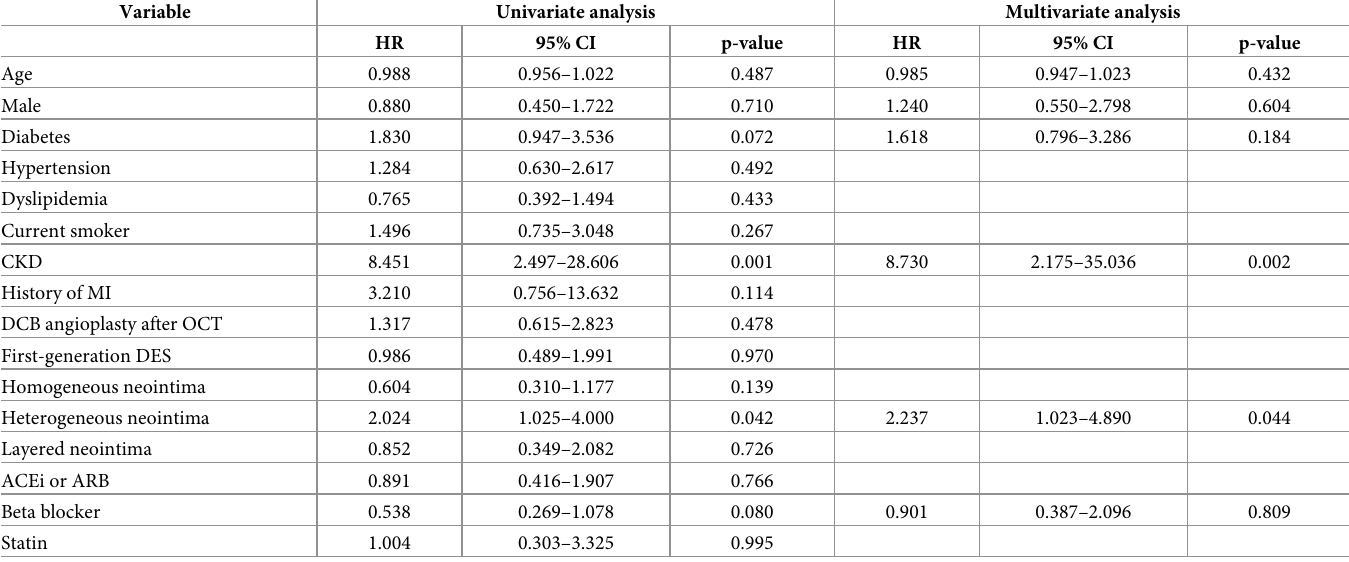
Table 3. Independent predictors for non-target lesion